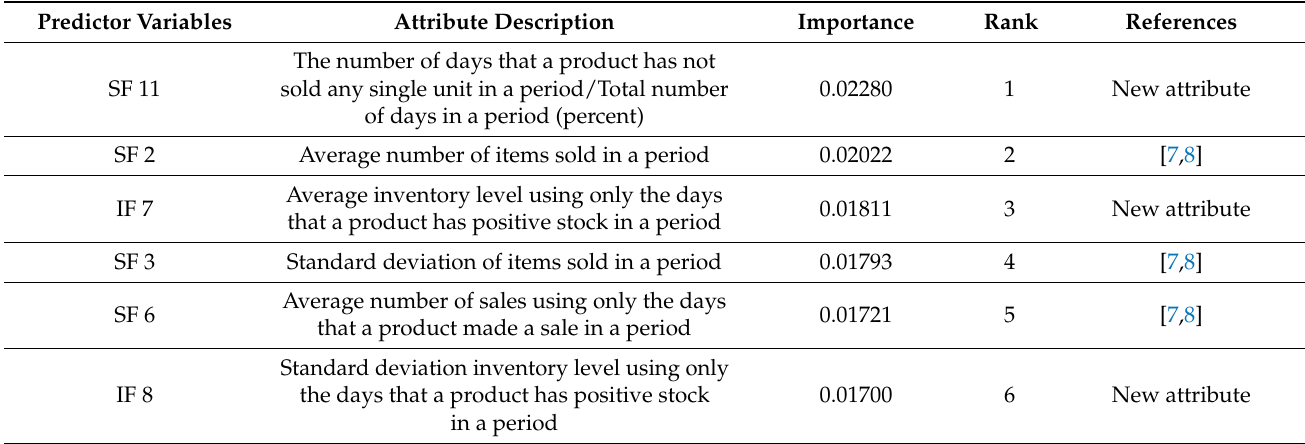
Figure 7. Predictor variables importance ranking. Table 5. Top 15 Predictor variables ranking.